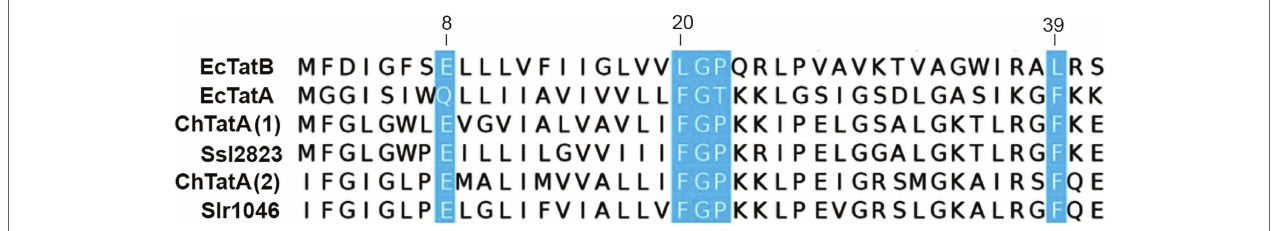
FIGURE 3 | Alignment of TatA proteins from Chroococcidiopsis sp. CCMEE 029. ChTat1 and ChTat2 aligned with homologs from Synechocystis sp. PCC 6803 (Slr1046 and Ssl2823) and Escherichia coli (EcTatA and EcTatB). Conserved residues of EcTatA, EcTatB are highlighted in blue. Numbering corresponds to EcTatA and EcTatB.